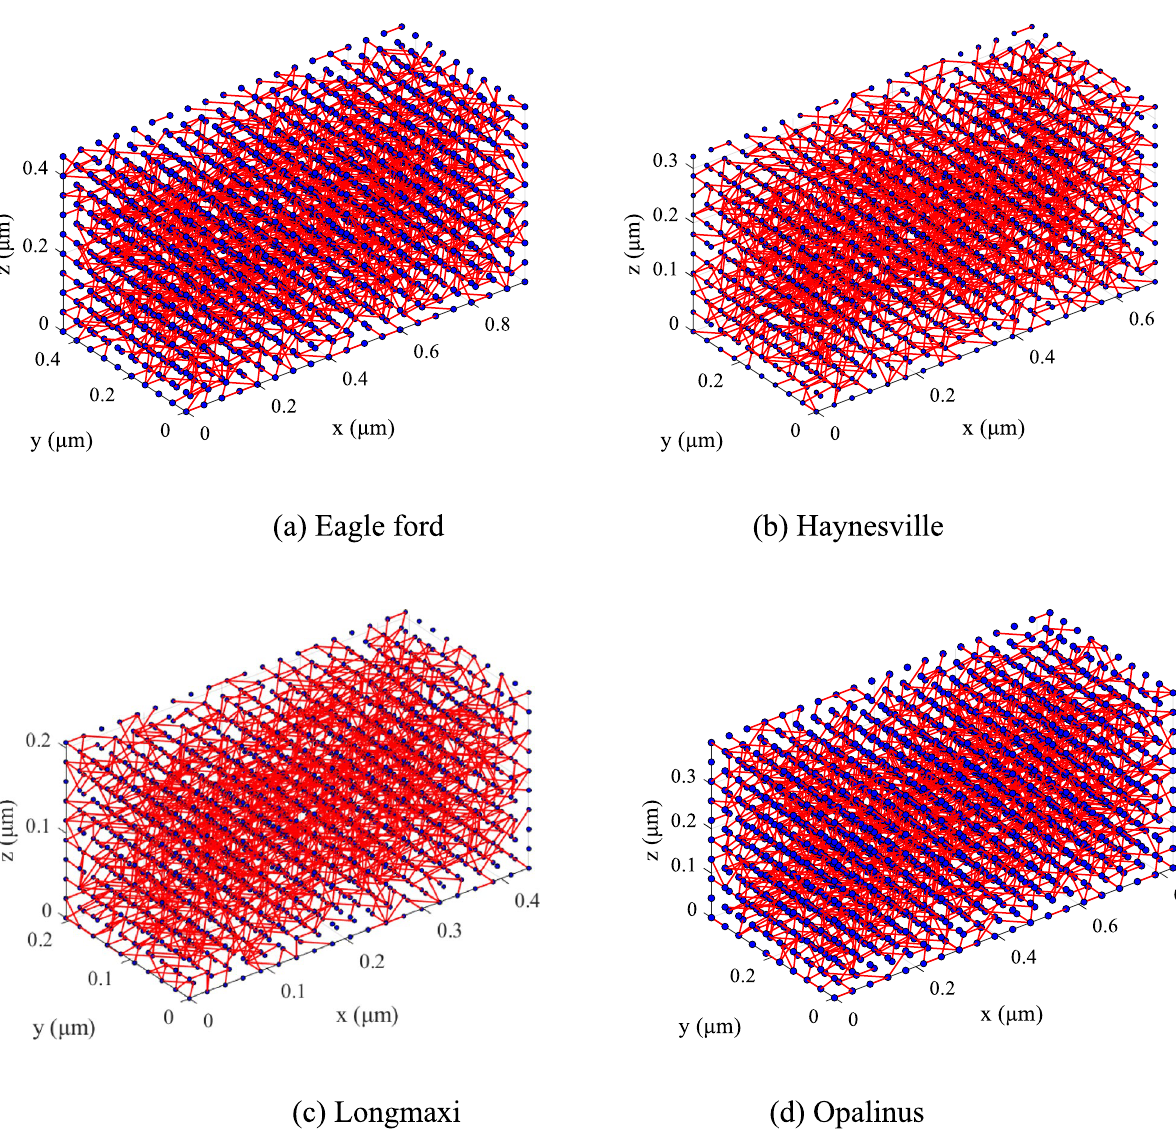
Figure 1. The schematic diagrams of the PNMs of the four types of